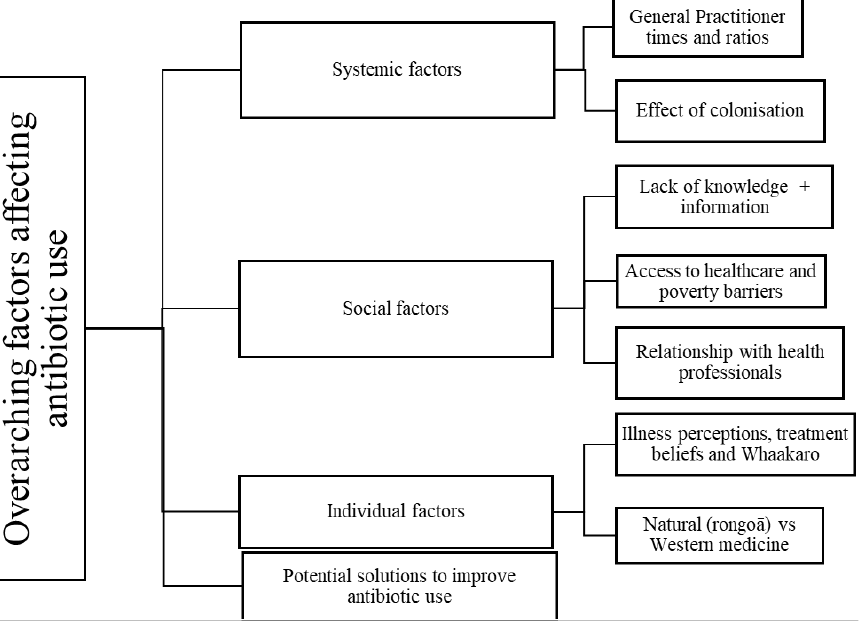
Figure 1. Themes regarding antibiotic use derived from interviews with 30 participants.